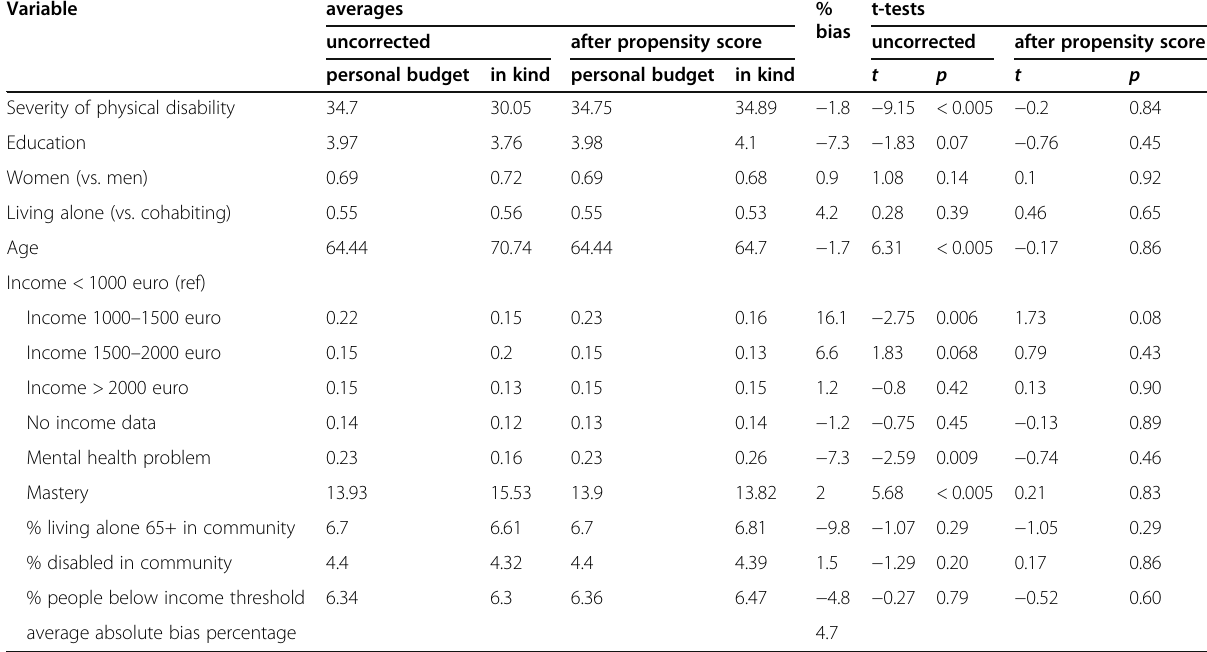
Table 1 Characteristics of respondents (personal budget and help in kind), uncorrected and corrected ( n = 446) Variable averages % t-tests bias uncorrected after propensity score uncorrected after propensity